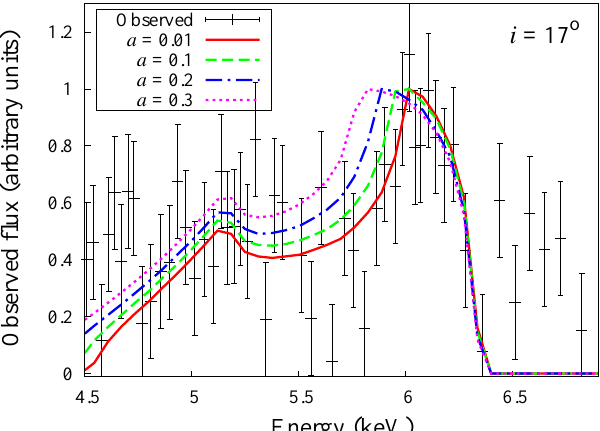
Fig. 3. Observations of the Fe K (cid:11) line in the case of the nucleus of Cygnus A (3C 405) (black crosses with error bars) observed by Chandra (Wilson et al. 2001), and the corresponding simulated profiles for four different values of the black hole